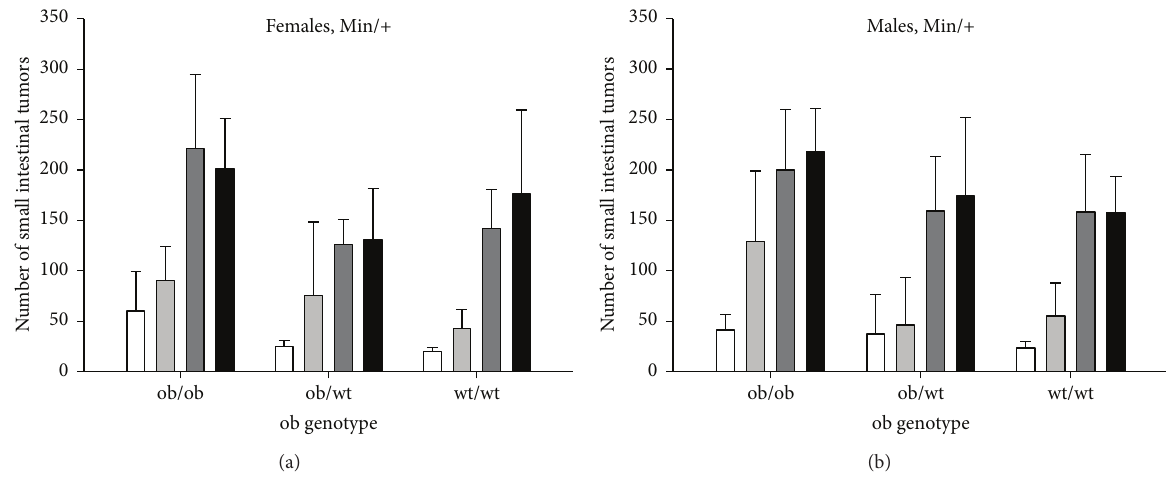
Figure 2: Number of small intestinal tumors. The number of small intestinal tumors (mean ± SD) is shown for (a) female and (b) male Apc Min/+ mice with the three ob genotypes, terminated at 11 weeks of age. The mice were exposed to 0.9% NaCl and given a 10% fat diet (white columns) or 0.9% NaCl and a 45% fat diet (light grey columns), or they were exposed to PhIP and given a 10% fat diet (dark grey columns) or PhIP and a 45% fat diet (black columns). 𝑛 = 10 –17